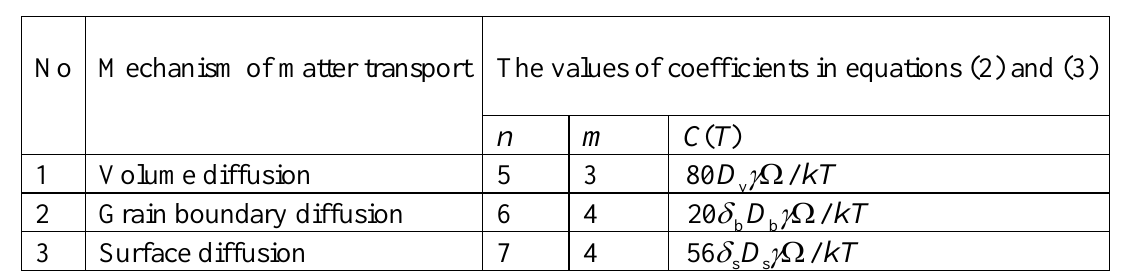
Table 2. Initial-stage sintering equations [9].